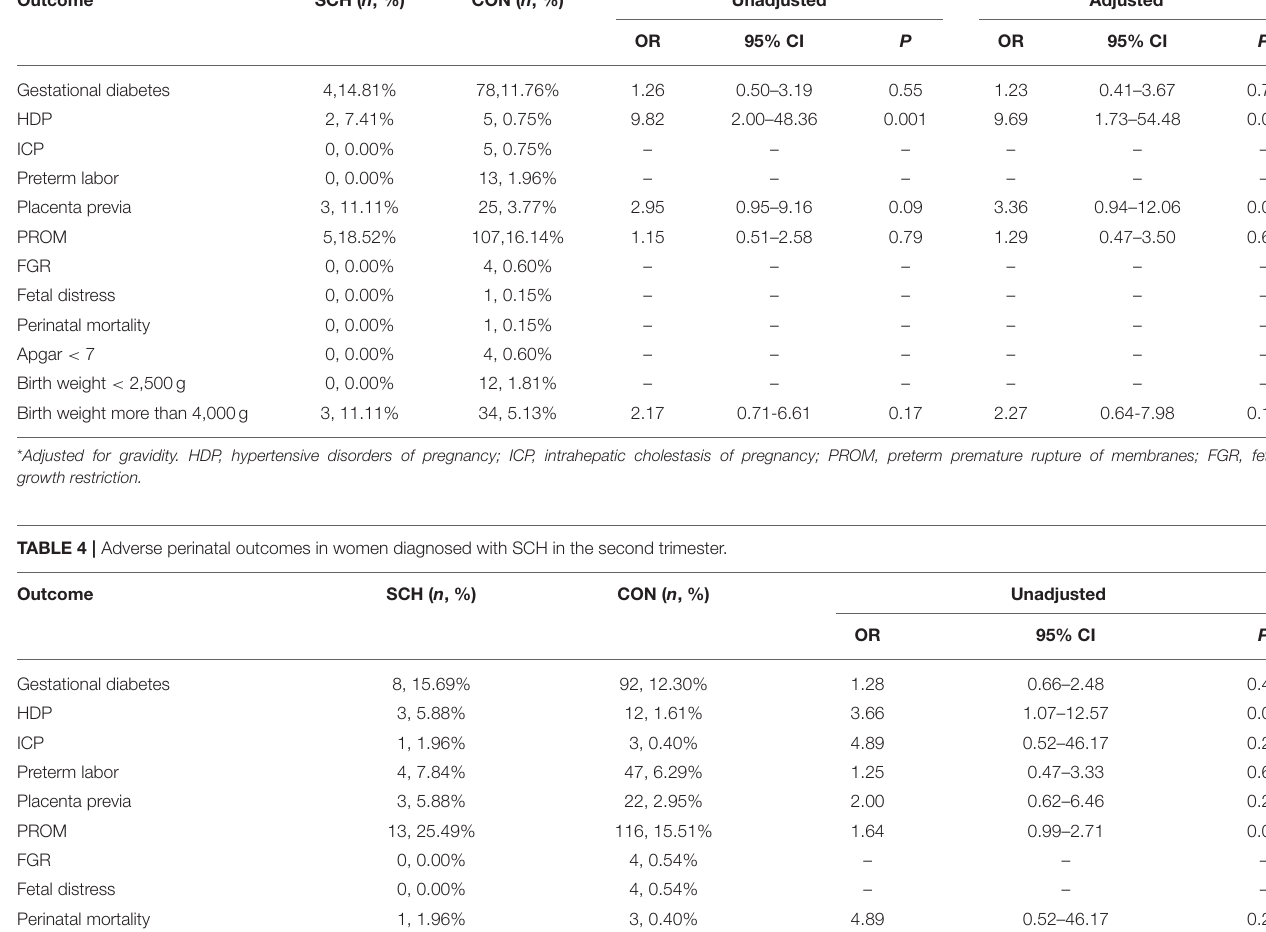
TABLE 3 | Adverse perinatal outcomes in women diagnosed with SCH in the first trimester. Outcome